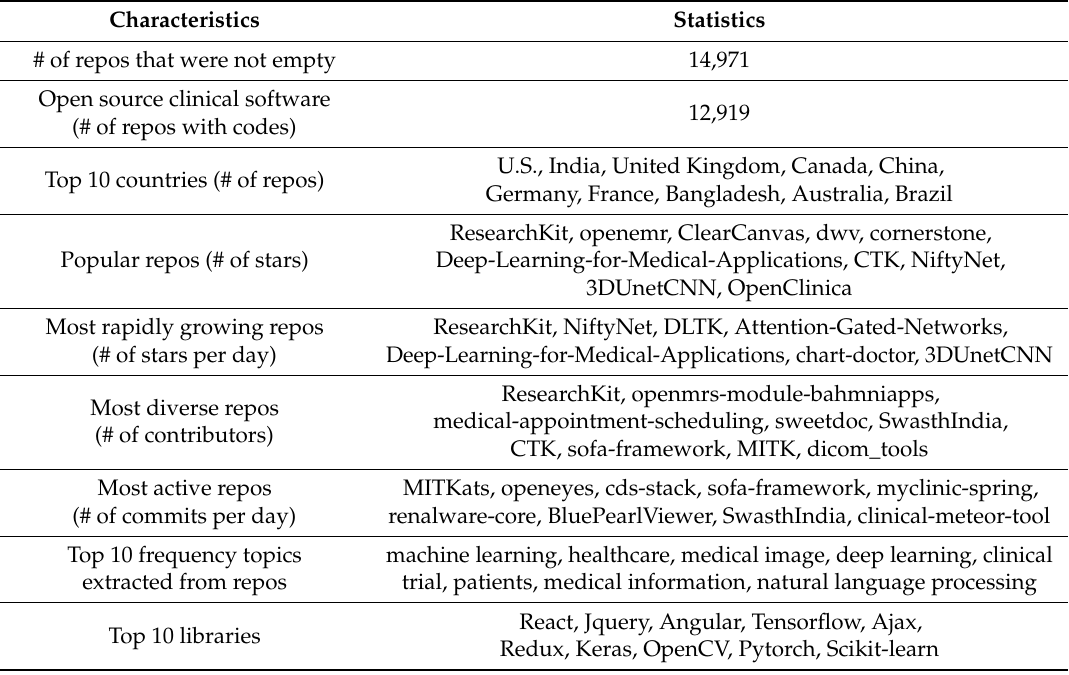
Table 4. Overview of open source clinical